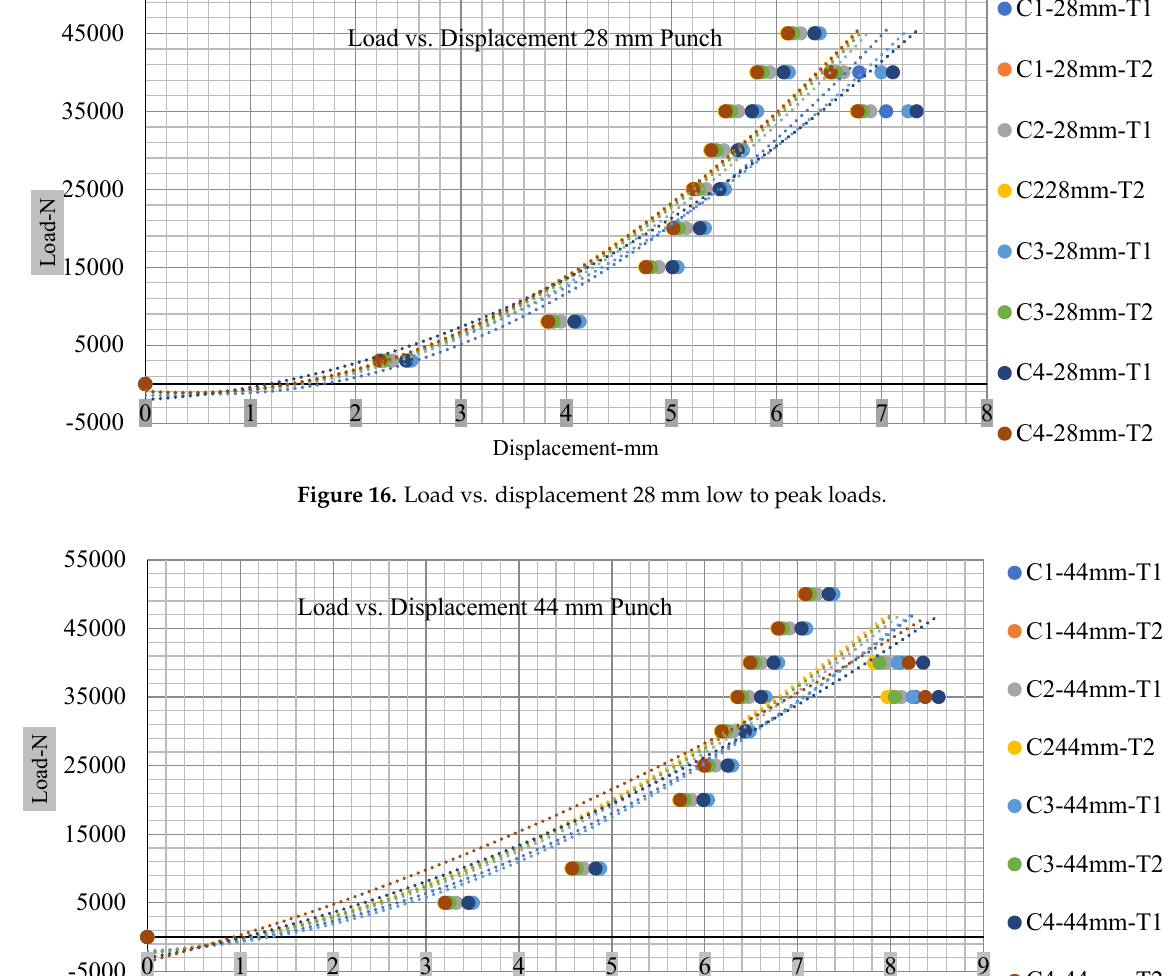
Figure 15. Load vs. displacement 25 mm low to peak loads.